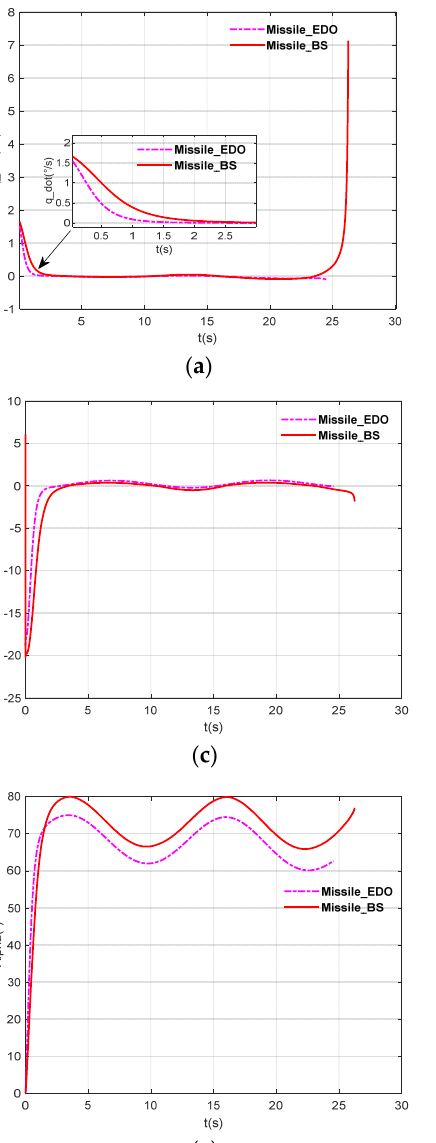
Figure 4. Missile–Target pursuit trajectory by using EDO and SMCBS.